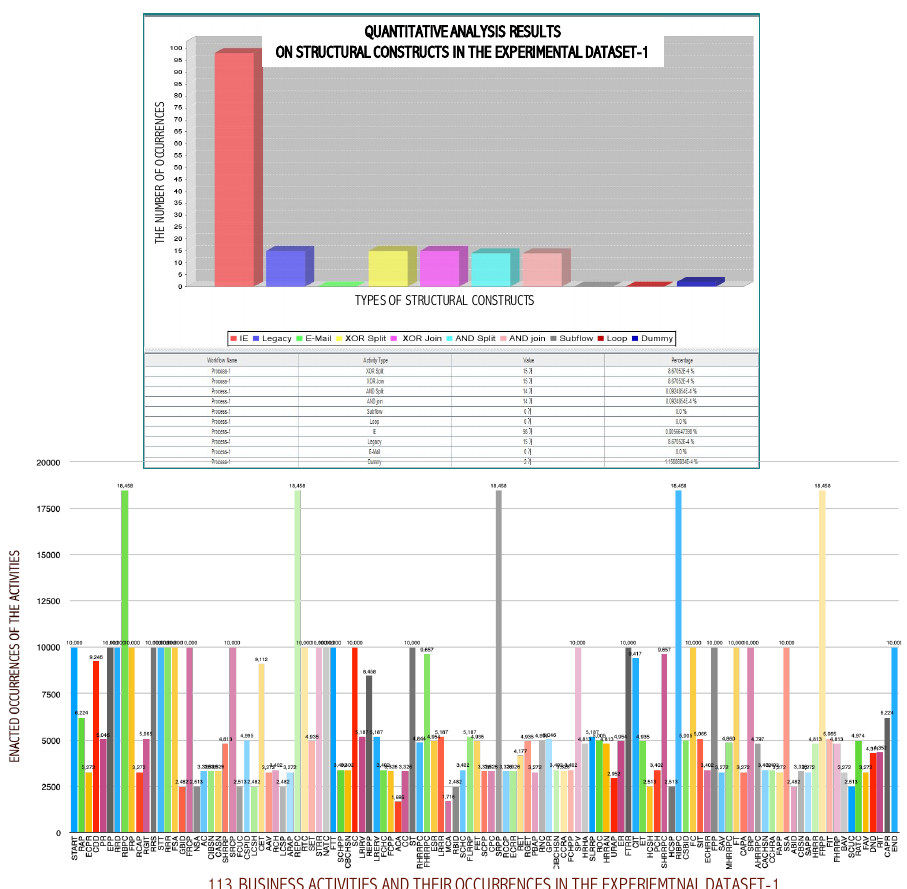
Figure 12. The quantitative analysis of structural constructs and business activities in the rediscovered SICN process model from the Experimental